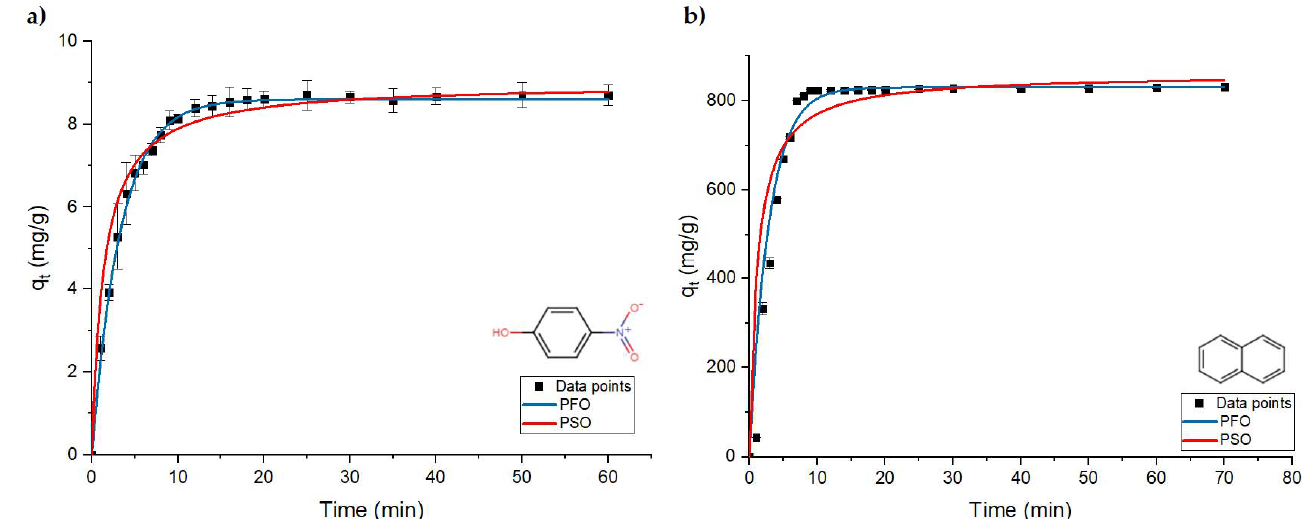
Figure 3. Kinetic profiles for the adsorption-based removal of model oil pollutants: ( a ) PNP and ( b ) naphthalene. The fitted lines correspond to the best-fit results for the PFO and PSO kinetic models. The corresponding best-fit kinetic parameters are listed in Table 2. The high correlation with the PFO model provides insight on the dependence of model pollutant (PNP or naphthalene) removal for the coagulation process. Based on the R 2 values, the PNP and naphthalene uptake with ferric sulfate obeys the PFO model because of its higher R 2 values, in contrast with the lower R 2 values obtained by the PSO model. Table 2. Kinetic adsorption parameters for ferric sulfate coagulation process for PNP and naphthalene.